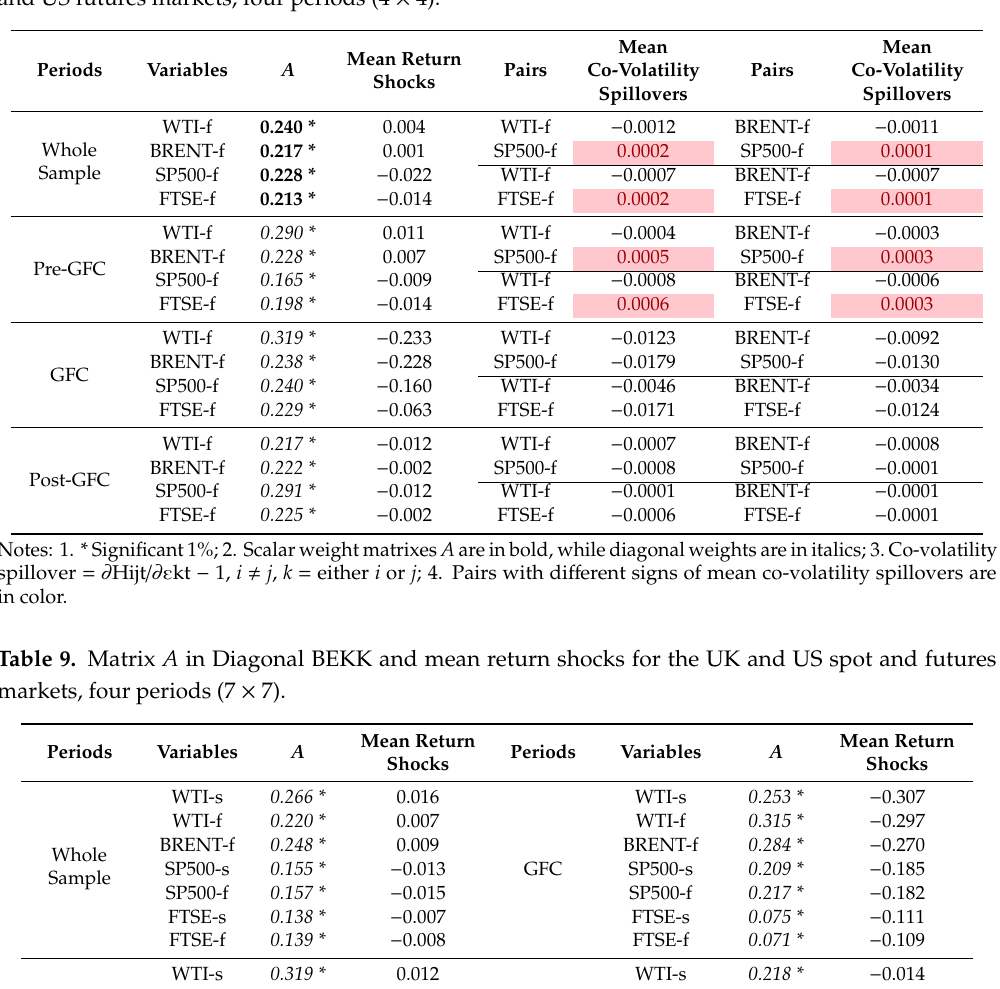
Table 8. Matrix A in Diagonal BEKK, mean return shocks, and mean co-volatility spillovers for the UK and US futures markets, four periods (4 × 4).